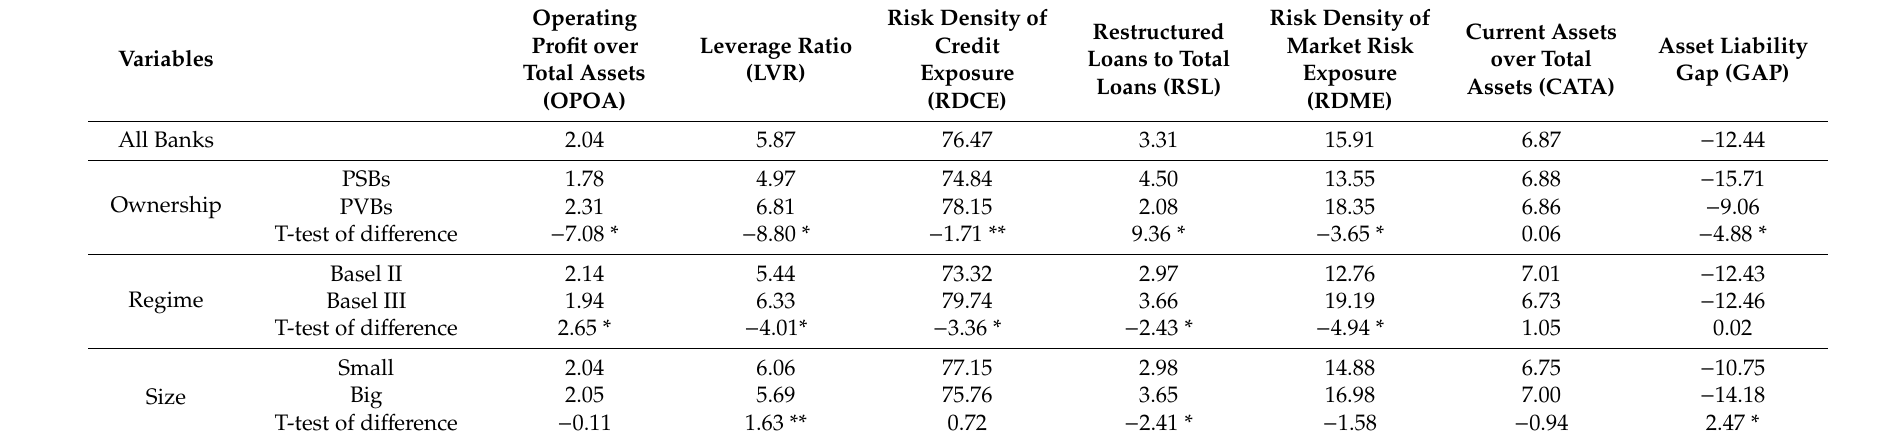
Table 1. Mean of the